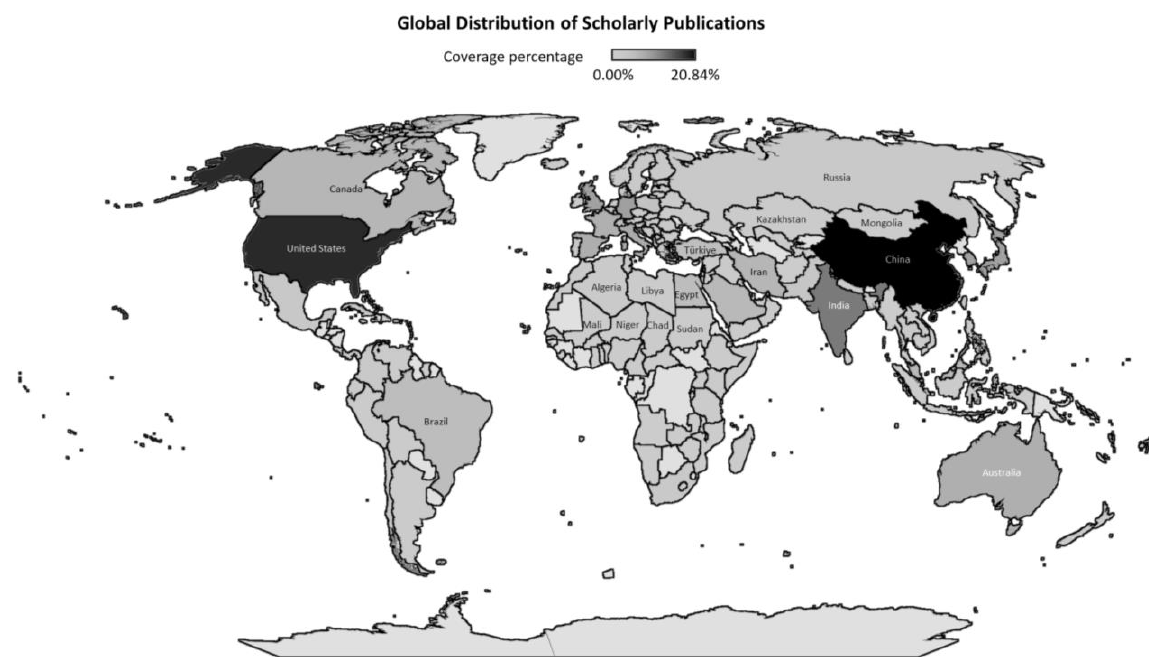
Figure 7. Global distribution of scholarly publications.